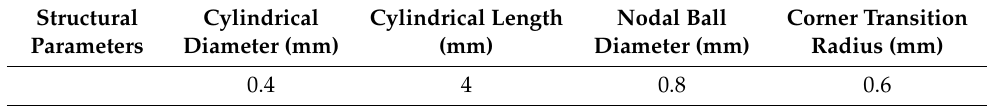
Figure 4. Nephogram of simulated compressive stress, strain, and deformation of bone scaffold: ( a ) optimized BCC Structure, ( b ) finite element stress distribution nephogram, ( c ) finite element displacement distribution nephogram, and ( d ) diagonal strain distribution in bone scaffold. Table 3. Optimization of BCC structure model